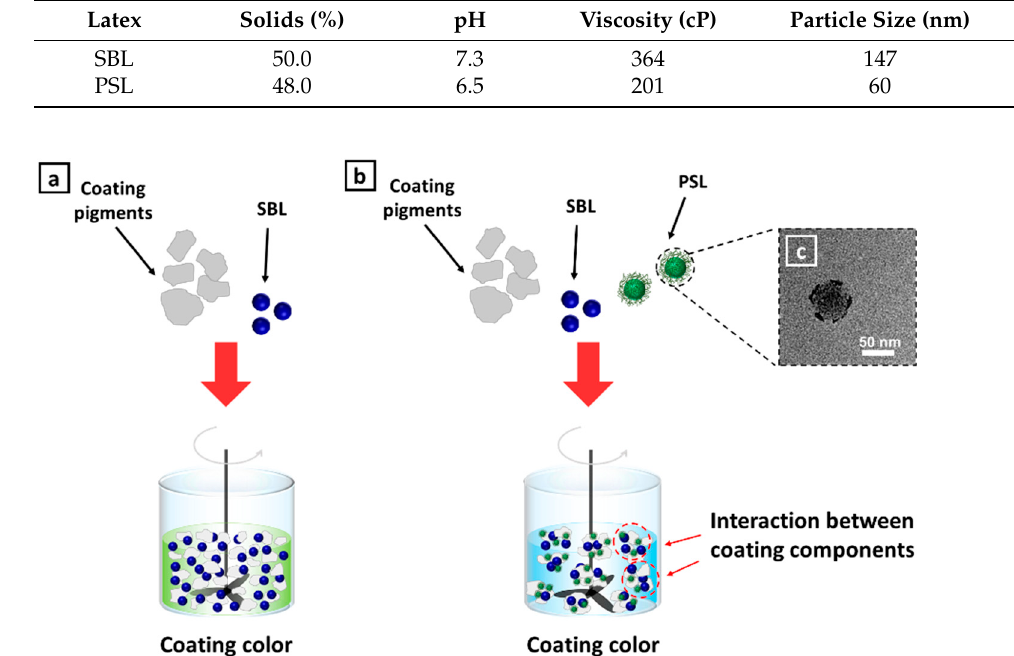
Figure 2. ( a ) Schematic illustrating the coating components and dispersion (i.e., coating color) obtained when only styrene/butadiene (S/B) latex (SBL) was used, ( b ) schematic illustrating the coating components and influence of the addition of the polymer-stabilized (PS) latex cobinder on a coating color, and ( c ) transmission electron microscopy image of a PS latex particle.